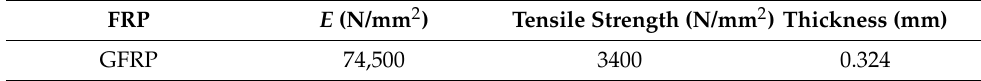
Table 2. Material properties of GFRP.